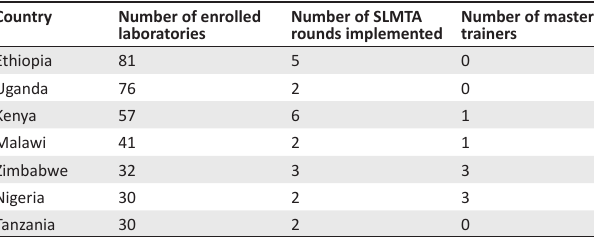
TABLE 3 : Number of master trainers in countries with the most enrolled SLMTA laboratories. Country Number of enrolled laboratories